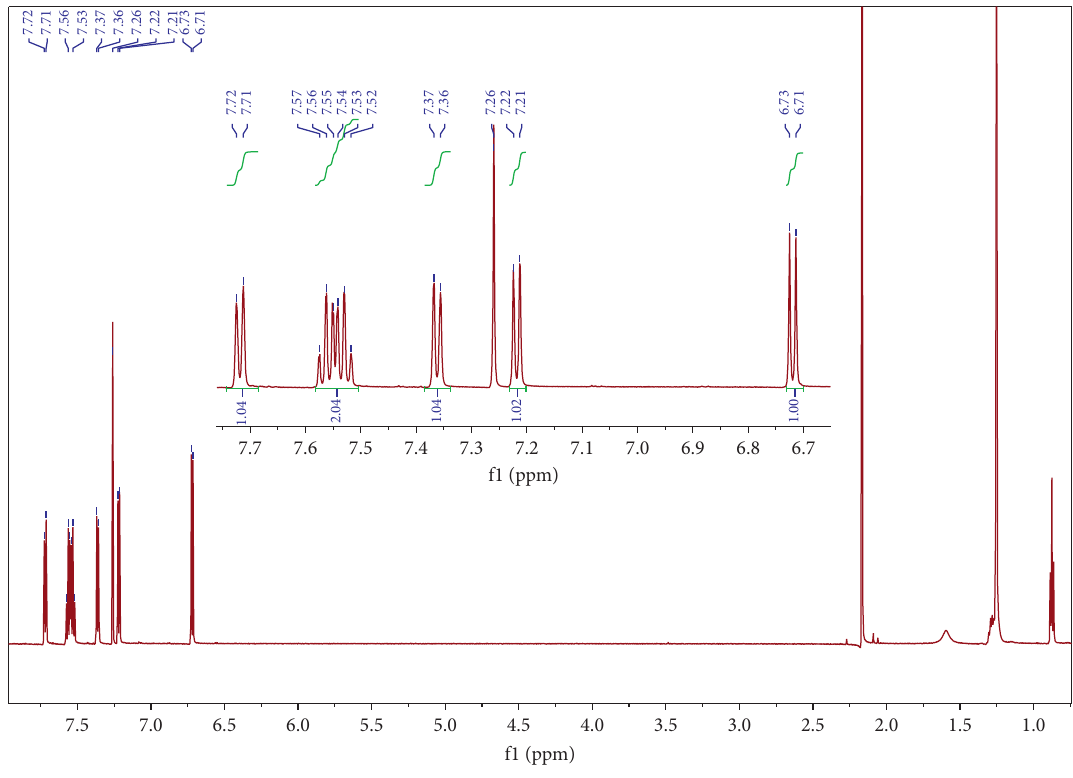
Figure 4: 1 H NMR of benzothiophene sulfone in CDCl